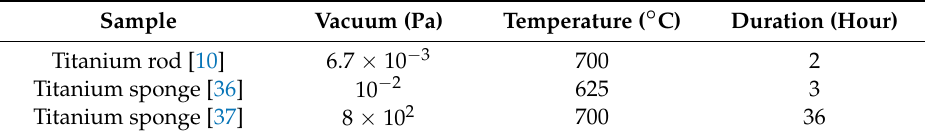
Table 3. Important dehydration parameters used in different